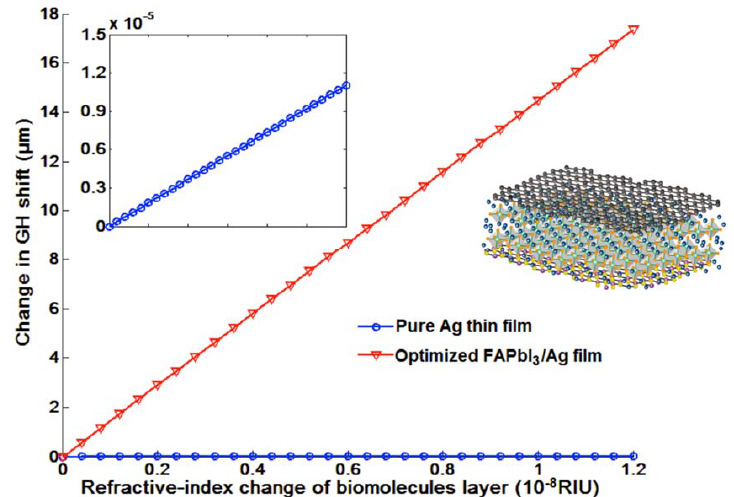
Figure 9. GH sensitivity comparison with (red curve) and without (blue curve) optimized 2D perovskites (FAPbI 3 ) layer for a narrow refractive index change up to 10 –8 RIU.